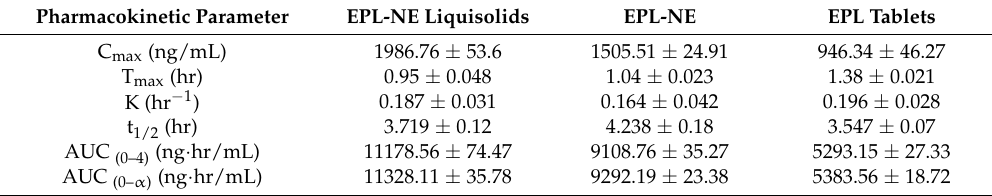
Table 4. Mean pharmacokinetic parameters of EPL after administration to rabbits in different forms.